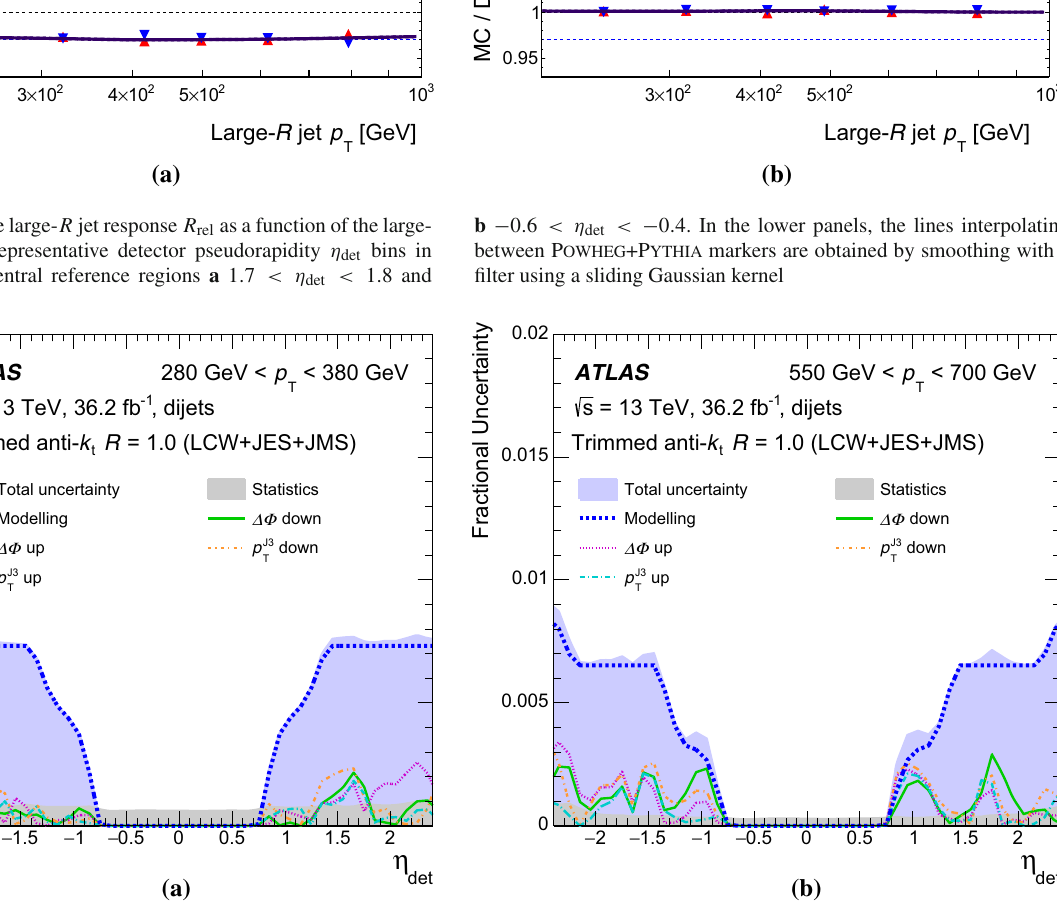
Fig. 6 Uncertainties associated with the large- R jet η -intercalibration using variations of the dijet topology selection are negligible relative to the simulation modelling uncertainty, which typically amounts to a 1% as a function of detector pseudorapidity η det in two representative aver- < 380 GeV uncertainty for large- R jets within 0 . 8 < | η det | < 2 . 0 age transverse momentum p avg bins a 280 GeV < p avg T T < 700 GeV. The uncertainties evaluated and b 550 GeV < p avg T